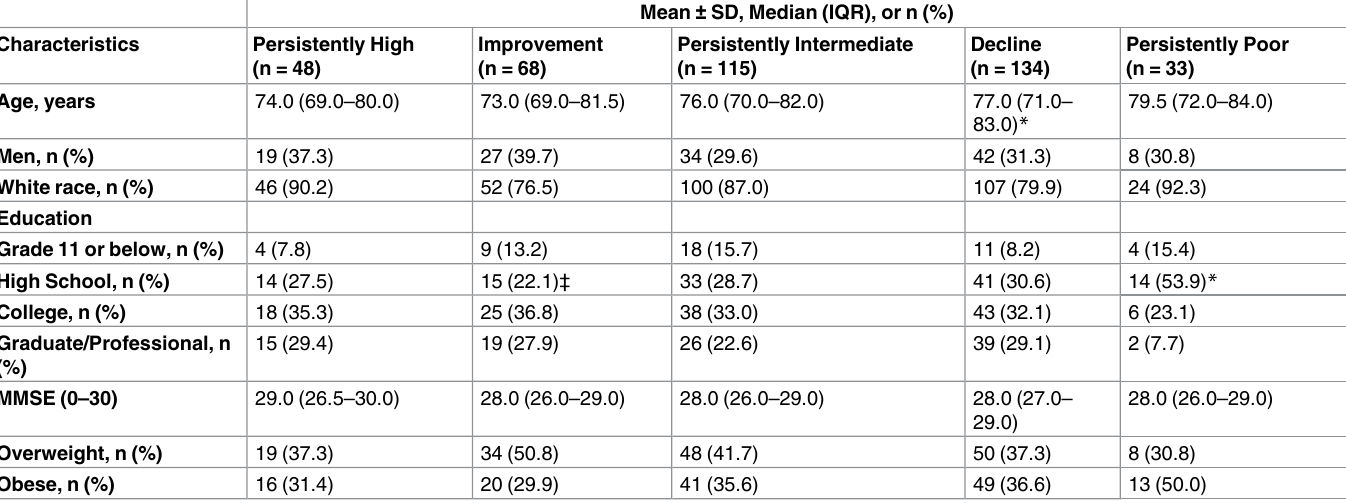
Table 1. Baseline characteristics by ALE mobility trajectoryover 2 year follow-up (N = 391).